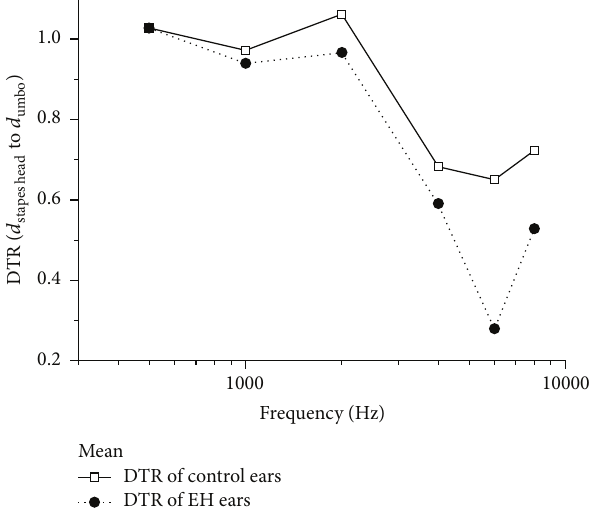
Figure6:Displacementtransmissionratio(DTR)ofthestapeshead to the umbo (mean value, 𝑛 = 6 ) in control ears (solid line), and ears with endolymphatic hydrops (EH; dotted